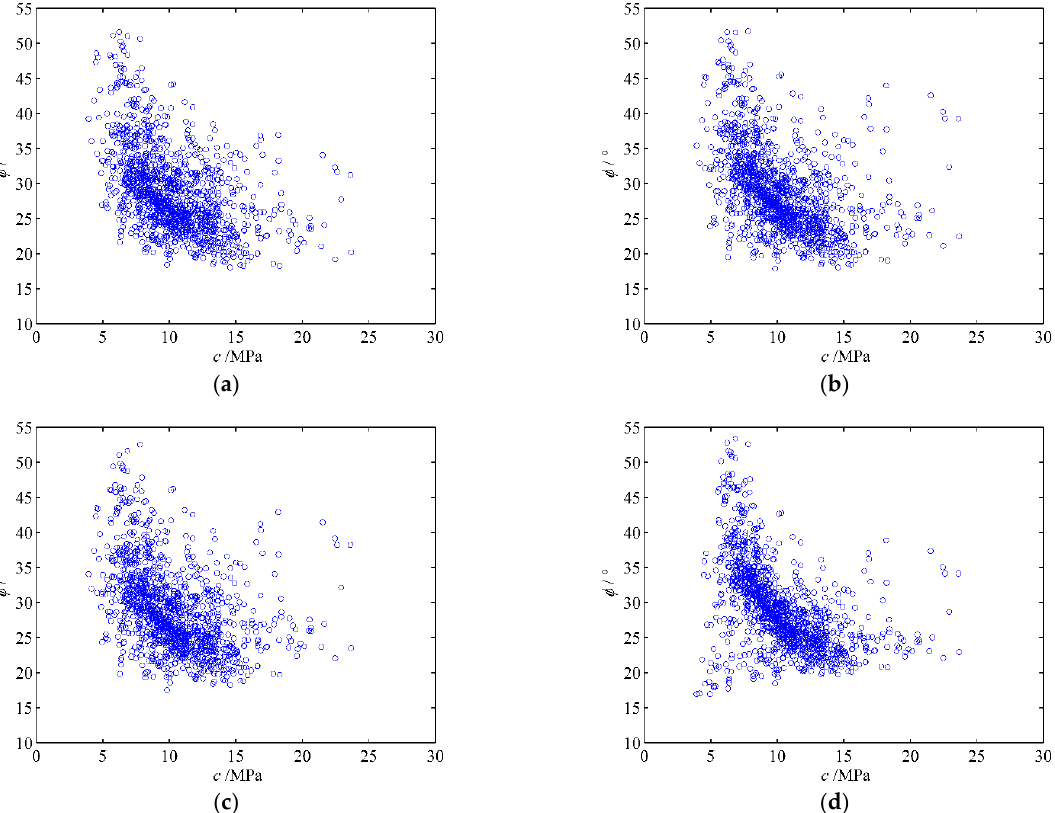
Figure 8. Scatter plots of soil parameters associated with different CCRFs. ( a ) Gaussian copula. ( b ) Plackett copula. ( c ) Frank copula. ( d ) No. 16 copula.